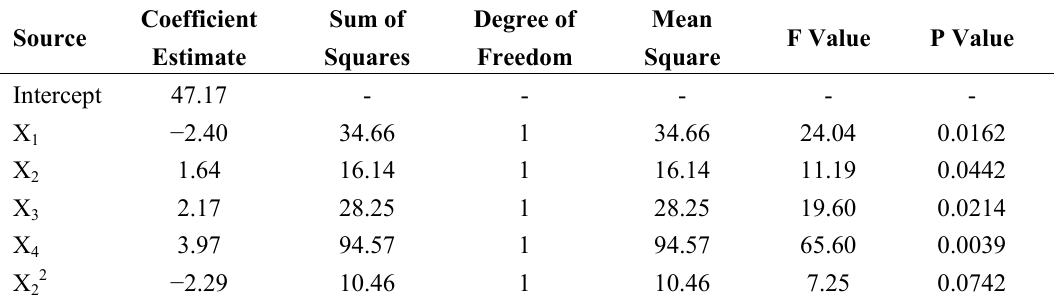
Table 4. Analysis of Variance (ANOVA) and Regression Coefficients of TEA-based esterquat cationic surfactant reaction (Linear model). Coefficient Sum of Degree of Mean Source F Value P Value Estimate Squares Freedom Square Intercept 47.17 - - - - - X − 2.40 34.66 1 34.66 24.04 0.0162 1 X 1.64 16.14 1 16.14 11.19 0.0442 2 X 2.17 28.25 1 28.25 19.60 0.0214 3 X 3.97 94.57 1 94.57 65.60 0.0039 4 X 22 − 2.29 10.46 1 10.46 7.25